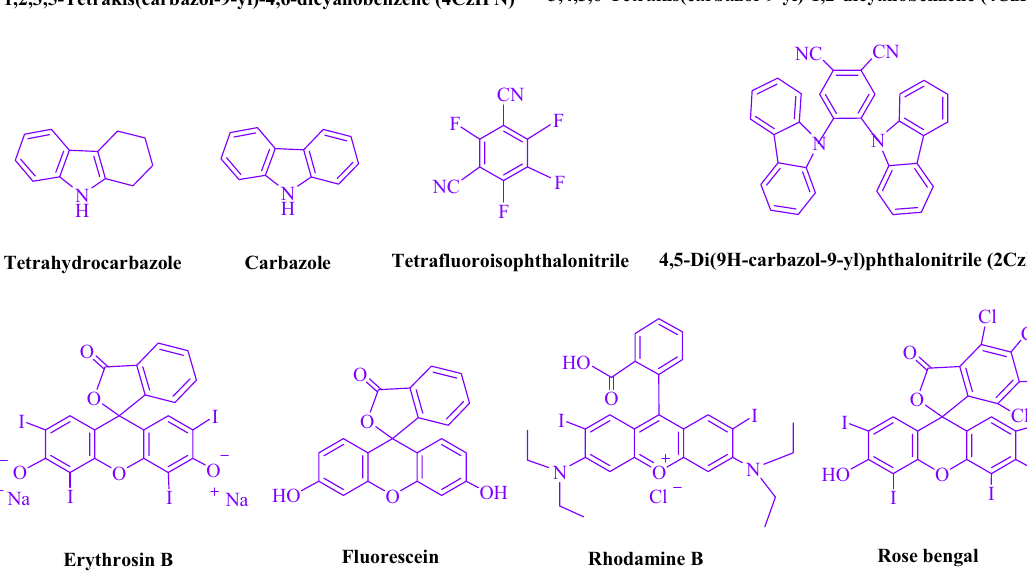
Figure 3. Catalyst performance in this investigation was